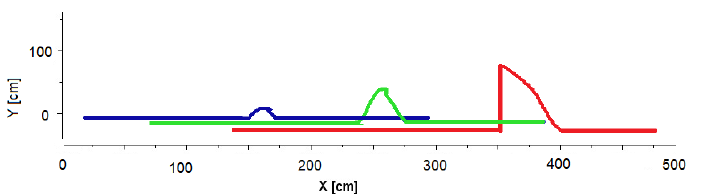
Figure 15. Trajectories of the quadrotors in Experiment 2. Color code: red, green and blue correspond to leader, mid and rear drones.